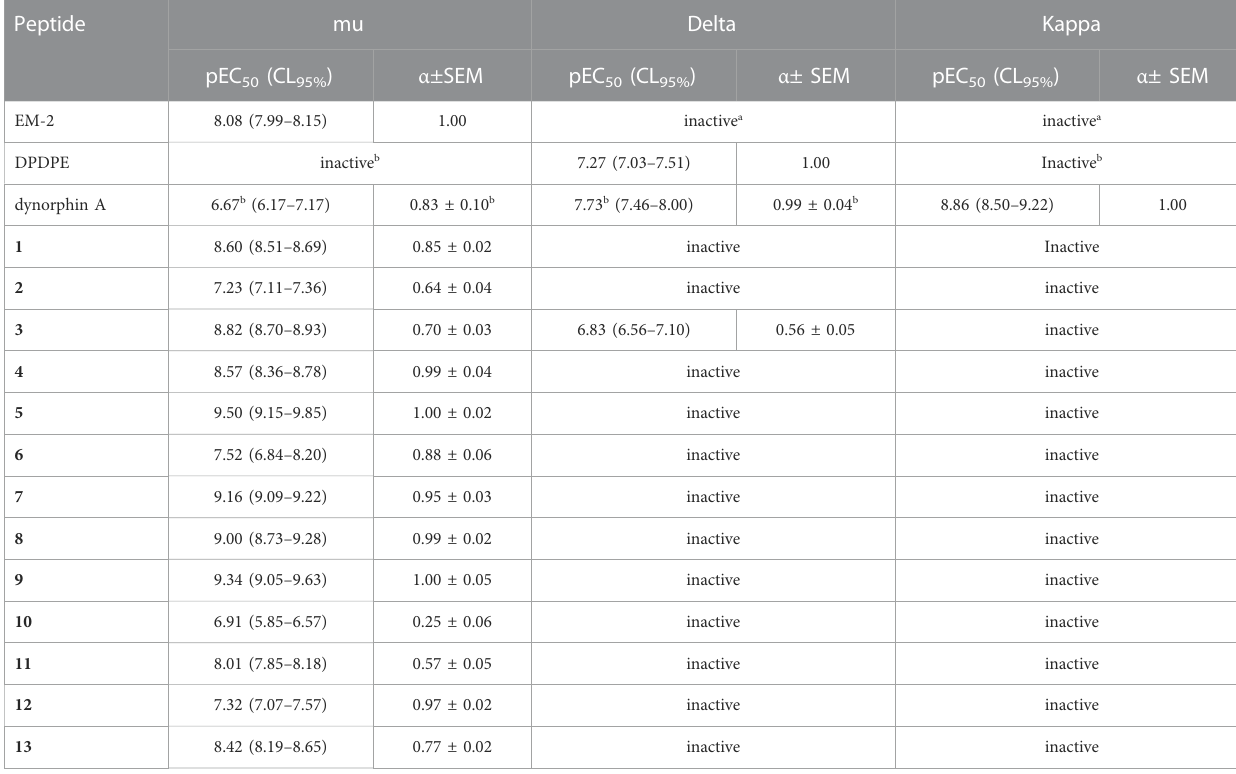
TABLE 3 Effects of reference agonists and novel peptides at human recombinant opioid receptors in a calcium mobilization assay performed in cells expressing chimeric G proteins. Peptide